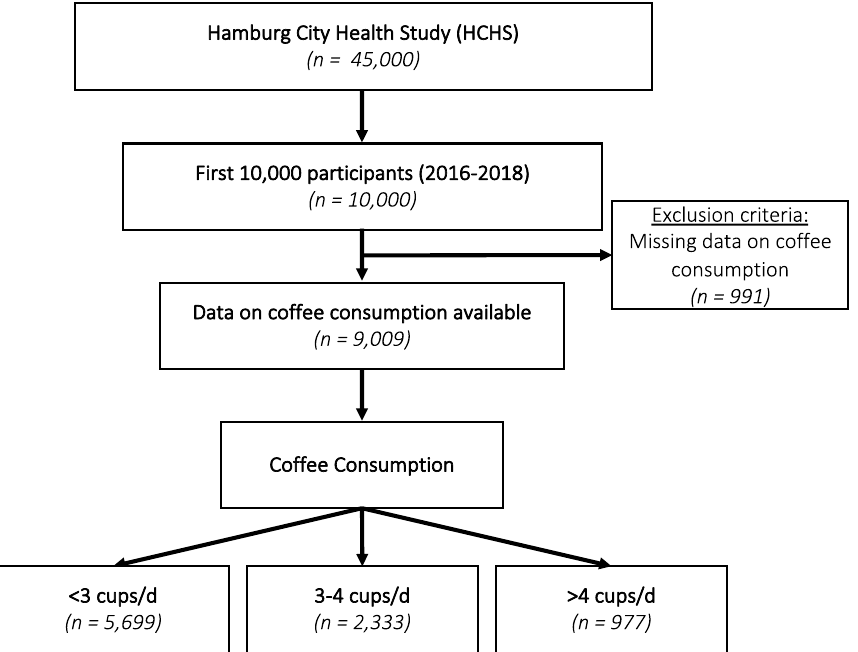
Figure 1. Study PRISMA. From a total of 10,000 subjects 9009 provided data on coffee consumption. The 9009 subjects were then stratified by their coffee consumption measured as cups per day